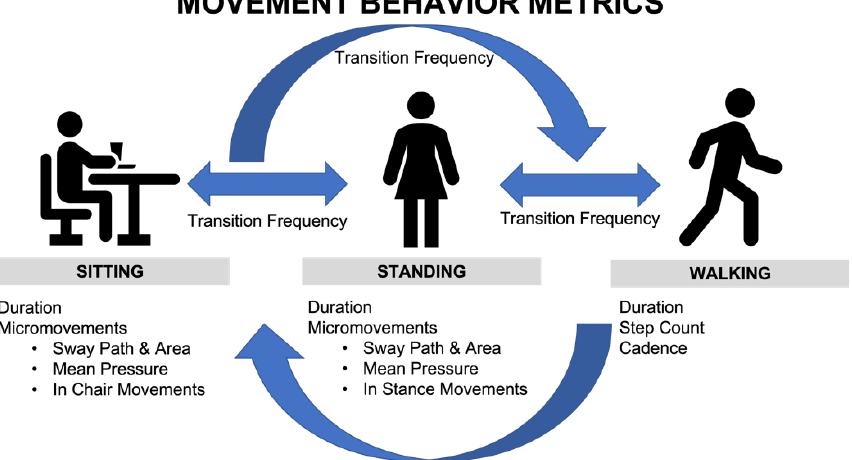
Figure 1. The comprehensive Movement Behavior Model for sedentary office workers. A transition is defined as a shift between two of sitting, standing, and walking. Each behavior was characterized by dedicated indicators.